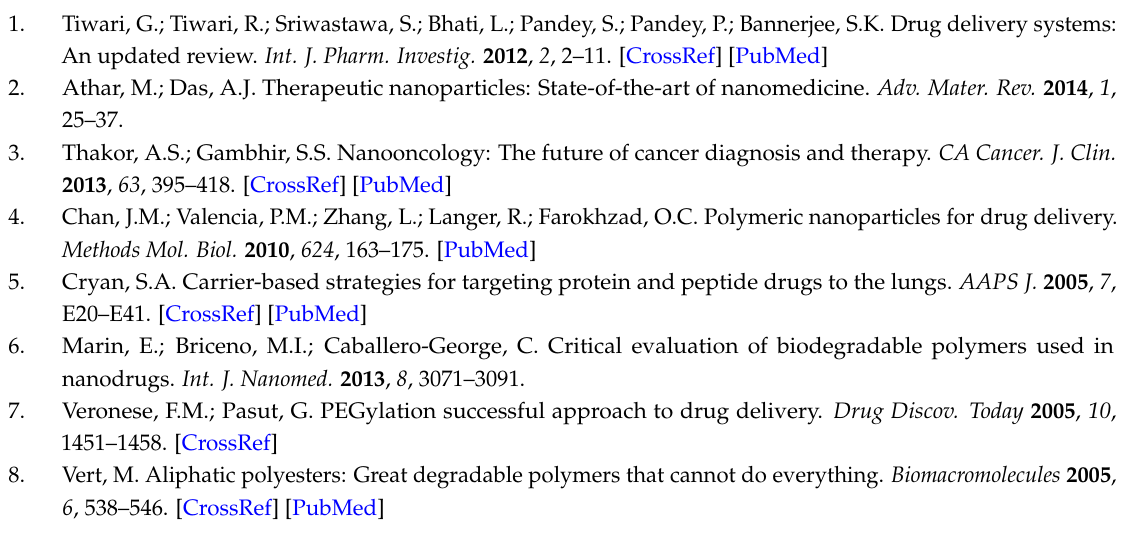
Figure 7. Evaluation of the produced protein nanoparticles: ( a ) TEM image; ( b ) scanning electron microscope (SEM) image; ( c ) confocal fluorescence image.